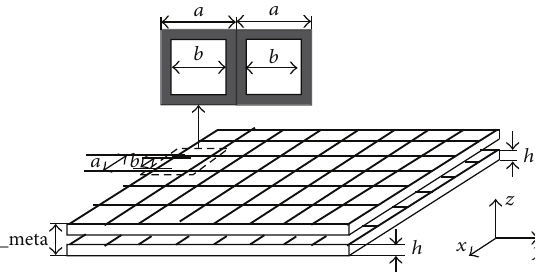
Figure 2: Metallic grids structure with low refractive